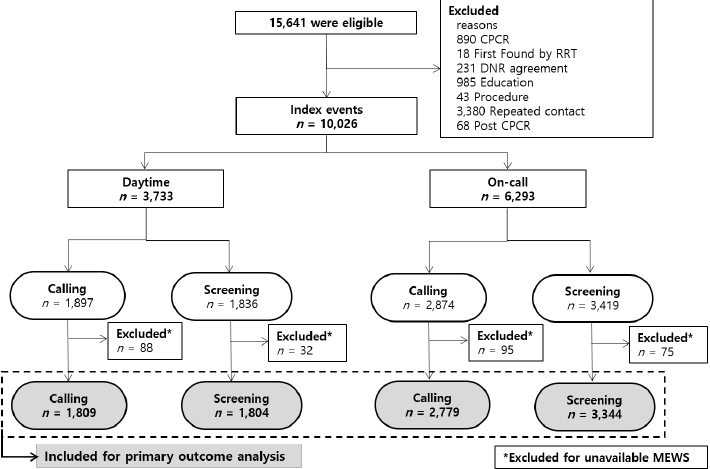
Figure 1. Schematic flow chart of the study Given that our rapid response team (RRT) performs a multifunctional role, only events related to early detection and management of at-risk patients were included for the study. Among 15,641 eligible events, 10,026 events were analyzed to describe the pattern of RRT activations. For clinical outcome analysis, 9736 events were included after excluding 290 events due to unavailable MEWS. Cardiopulmonary cerebral resuscitation (CPCR); Do not resuscitate (DNR); Rapid response team (RRT); Modified early weaning score